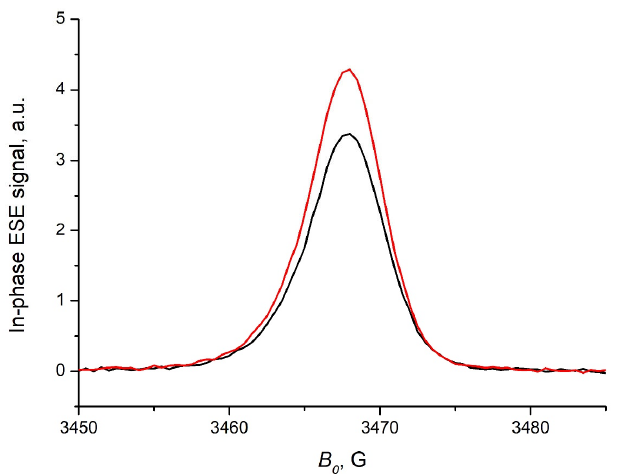
Figure 1. The echo-detected EPR spectra of the P3HT/s-SWCNT composite film obtained at 80 K in Figure 1. The echo ‐ detected EPR spectra of the P3HT/s ‐ SWCNT composite film obtained at 80 K in the dark (black line) and under continuous illumination (red the dark (black line) and under continuous illumination (red line).